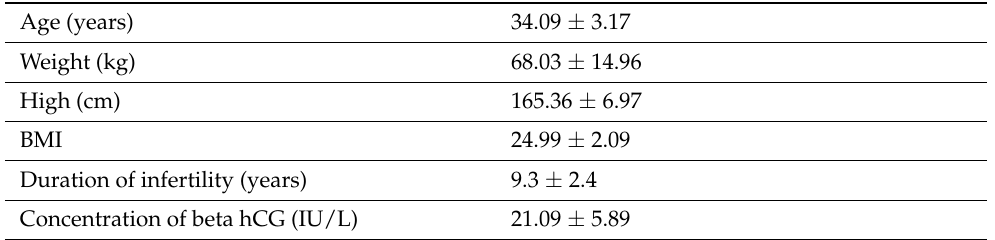
Table 1. Characteristics of women included in the study.